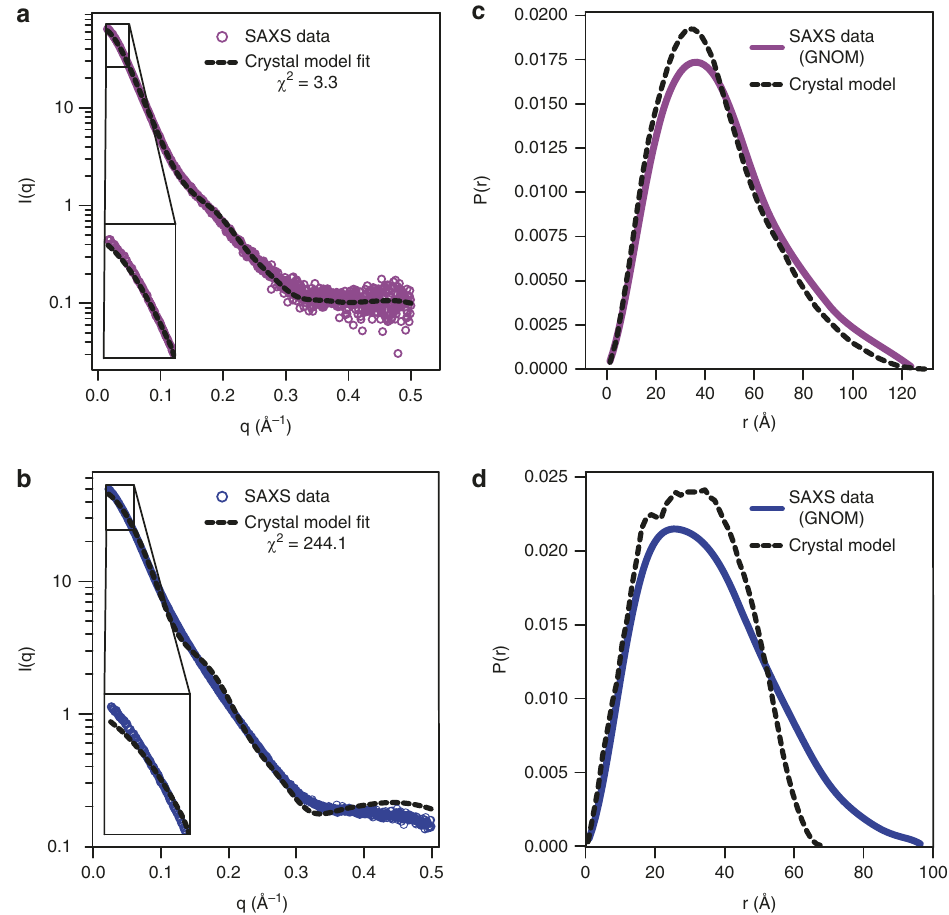
Fig. 2 Solution phase analysis of the dV – HAVx complex and standalone dV with SAXS. a Fitting of experimental SAXS pro fi le (scattering vector, q = 4 π sin θ / λ ) obtained by merging the datasets from 1 mg/ml, 2 mg/ml and 4 mg/ml concentrations for the dV – HAVx complex and b for the standalone dV against the scattering pro fi le calculated from the corresponding crystal structure models. Details of SAXS analysis for both standalone dV and dV – HAVx complex are provided in Supplementary Figs. 7 and 8, and Supplementary Table 1. c Pairwise distance distribution calculated from the experimental dataset and the corresponding crystal models for the dV – HAVx complex and d for the standalone